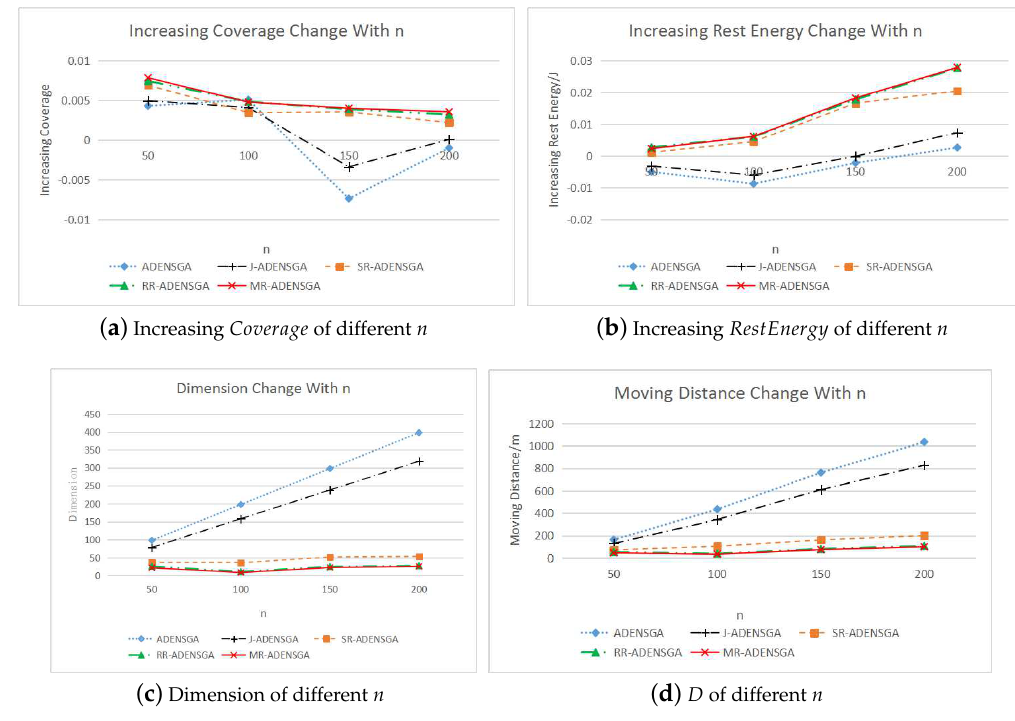
Figure 10. Comparison of Optimization Results for WSNs with Different